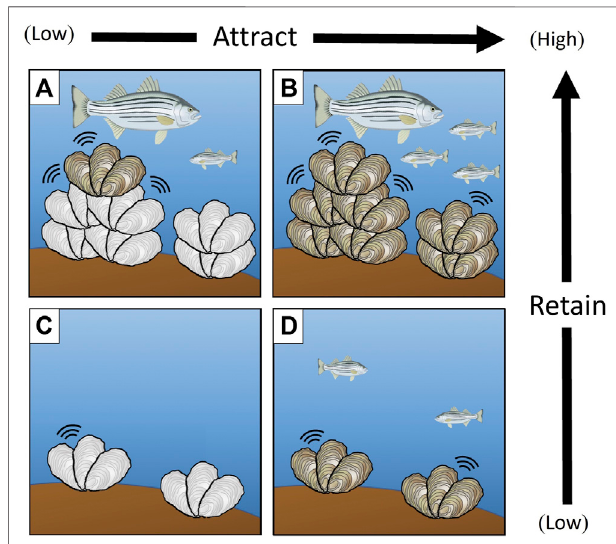
FIGURE 1 | The structural complexity and substrate composition of biogenic habitats (e.g., oyster reef, family Ostriedae ) host a range of visual, auditory, and chemosensory cues affecting the selection (attraction) and use (retention) of resident biota (e.g., Striped bass, Morone saxatilis ). Composition mediates a range of visual, auditory, and chemosensory cues thatattractresidentspecies.Structuralfeaturesin fl uencetheamountandtype of shelter space and foraging resources available, in fl uencing species retention. Studies integrating ecologically realistic arti fi cial habitats (white oysters) with live biogenic habitat (grey oysters) are a useful tool for disentangling the relative in fl uence of features affecting habitat selection (i.e., attraction) and use (i.e., retention). (A) Complex structural features and limited compositional cues are hypothesized to attract resident organisms at low rates, but retain organisms once attracted. (B) Complex structural features and high compositional cues are hypothesized to attract and retain species at high rates. (C) Few structural features or compositional cues are hypothesized to result in low species attraction and retention. (D) Few structural features but high compositional cues are hypothesized to attract organisms at high rates, but retain few organisms that are attracted.